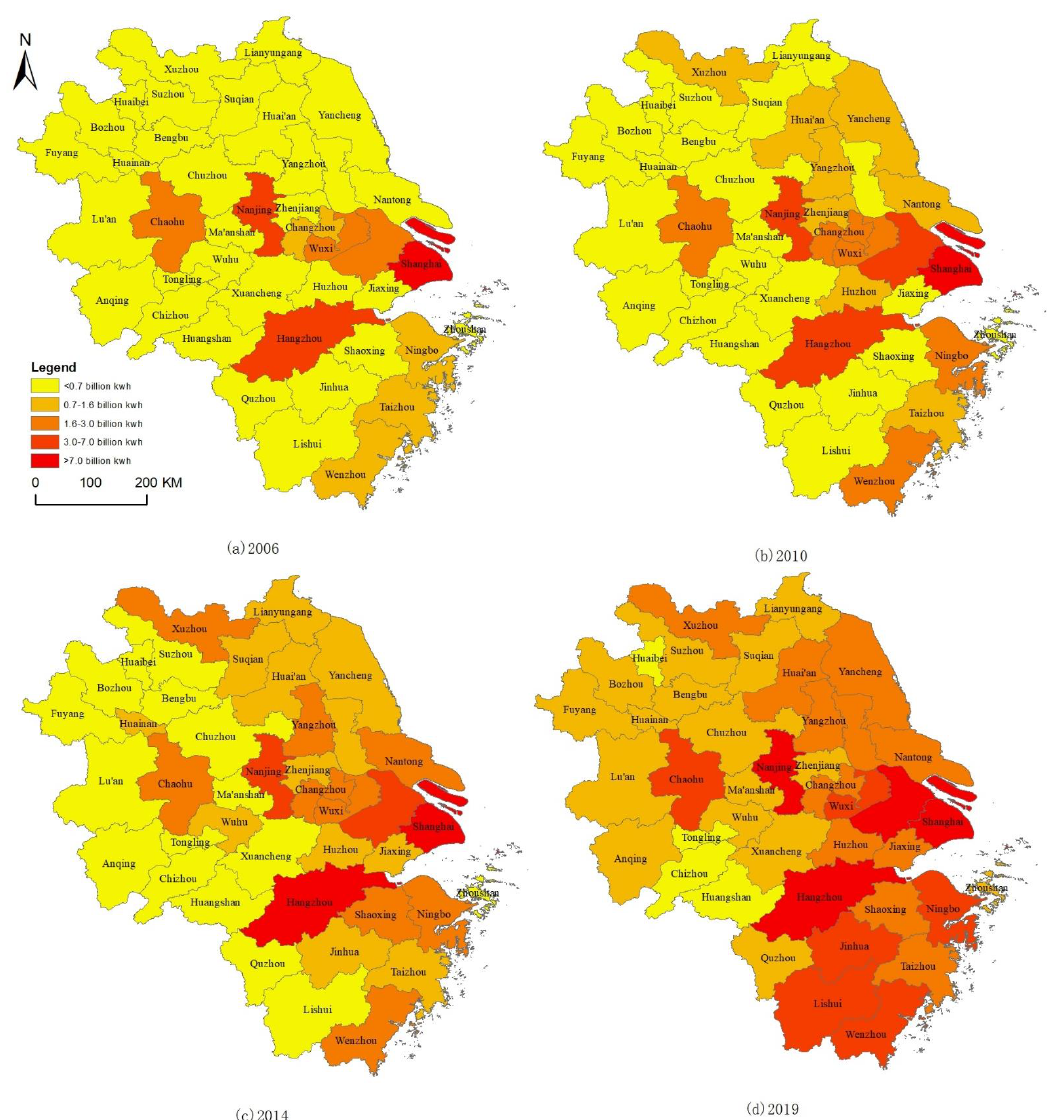
Figure 1. Spatiotemporal characteristics of electricity consumption in YRD region in 2006, 2010, 2014, 2019. As shown in Figure 1, the total final electricity consumptions of the cities of Suzhou, Hangzhou, Nanjing, and Shanghai were the highest of the 41 cities. Moreover, the electricity consumptions of Hefei, Wuxi, Changzhou, Wenzhou, and Ningbo were in the second echelon of the 41 cities in the YRD region, which indicated that there is a correlation between the city’s economic scale and electricity consumption. However, judging from the increasing rate of total final electricity consumption during 2006 – 2019, the cities where electricity consumption increased more than ten times in the past 13 years were Yancheng, Suqian, Shaoxing, Jinhua, Lishui, Fuyang, Bozhou, and Xuancheng. The electricity con- sumption of the aforementioned cities grew faster, but at a very low level in the initial period, and their electricity consumption in the final period was also in the lower reaches of the 41 cities. On the contrary, the growth rate of cities with higher electricity consump- tion levels tended to slow down. The total final electricity consumption of the 41 cities in the YRD region was classified as residential and industrial. In the gravity model described in Section 2.1.1, each city’s geographic coordinates of center of gravity and electricity consumption reflect the center of gravity coordinates for the three types of electricity consumption from 2006 to 2019. The movement of the center of gravity is shown in Figure 2; the location and distance of the center of gravity is shown in Table 2.